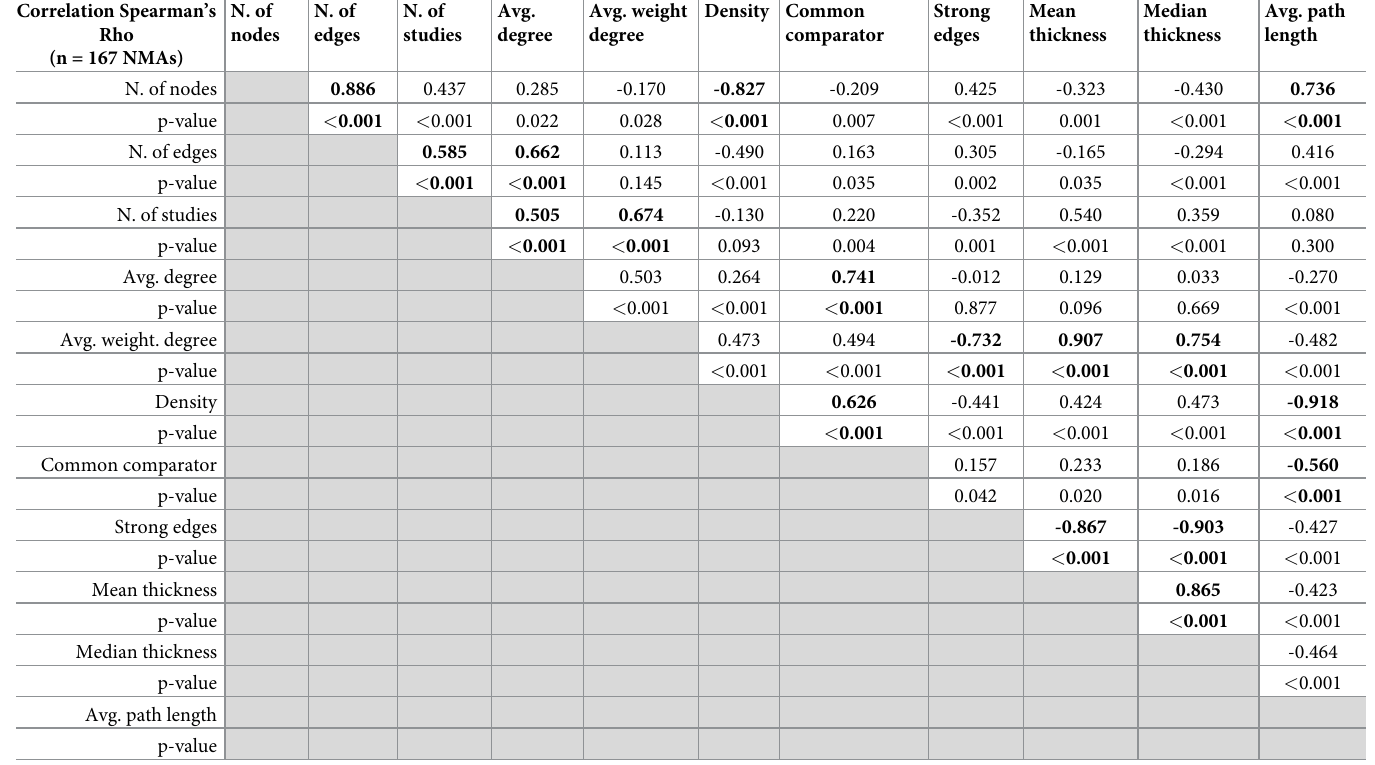
Table 3. Correlation analyses of NMA’s geometry parameters and